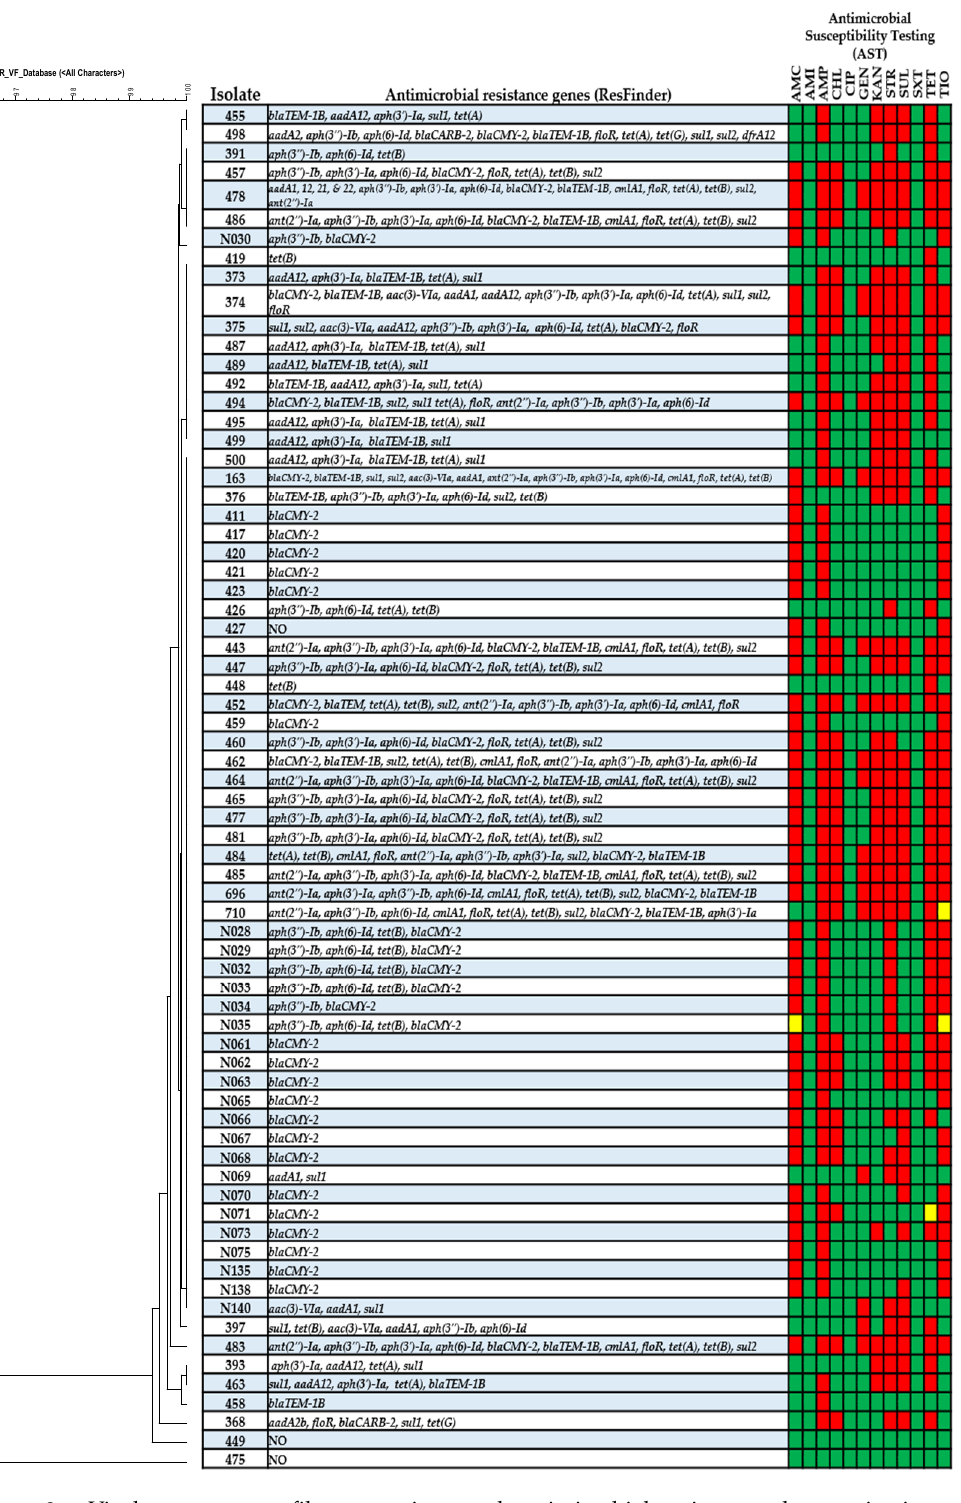
Figure 3. Virulence gene profile comparison and antimicrobial resistance characterization of the 71 Salmonella isolates. The dendrogram on the left is based on the phylogenetic comparison of 491 virulence or putative virulence genes described in Table S3. The columns to the right display the resistance genes identified and antimicrobial susceptibility testing results, where a red box indicates resistance, a green box susceptible and a yellow box indicates intermediate susceptible .